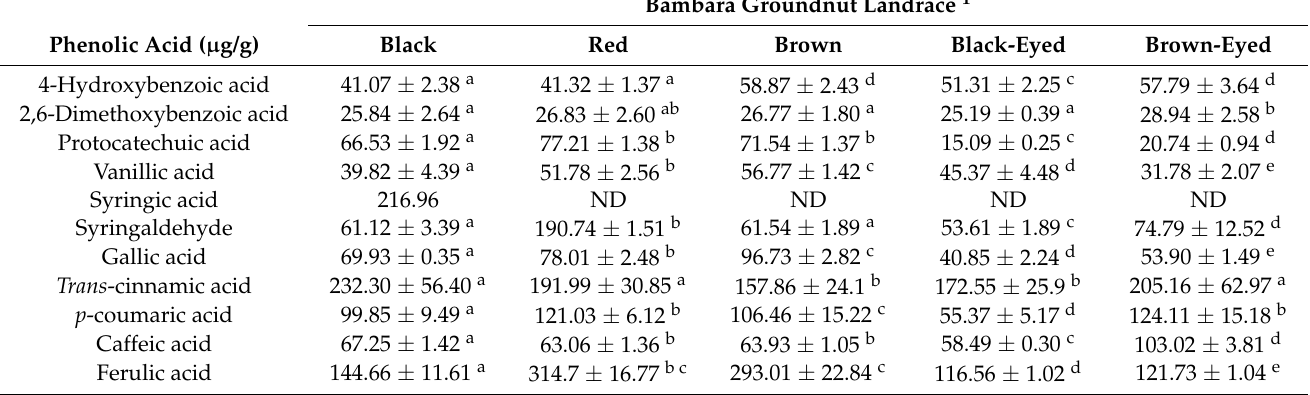
Table 3. Phenolic acid composition of ethanolic extracts prepared from the whole seeds of various Bambara groundnut